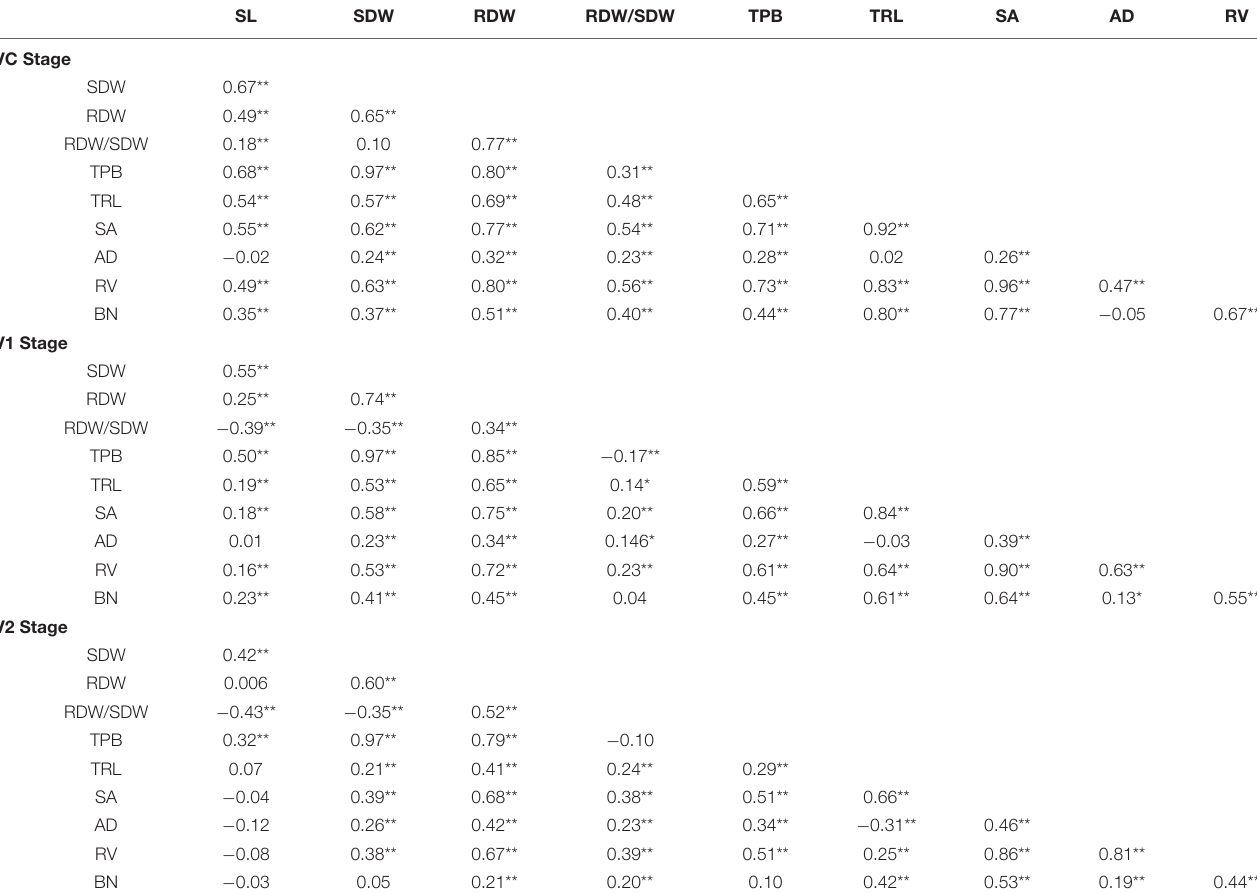
TABLE 3 | Pearson correlation coefficients among all seedling root and shoot traits at three stages. SL